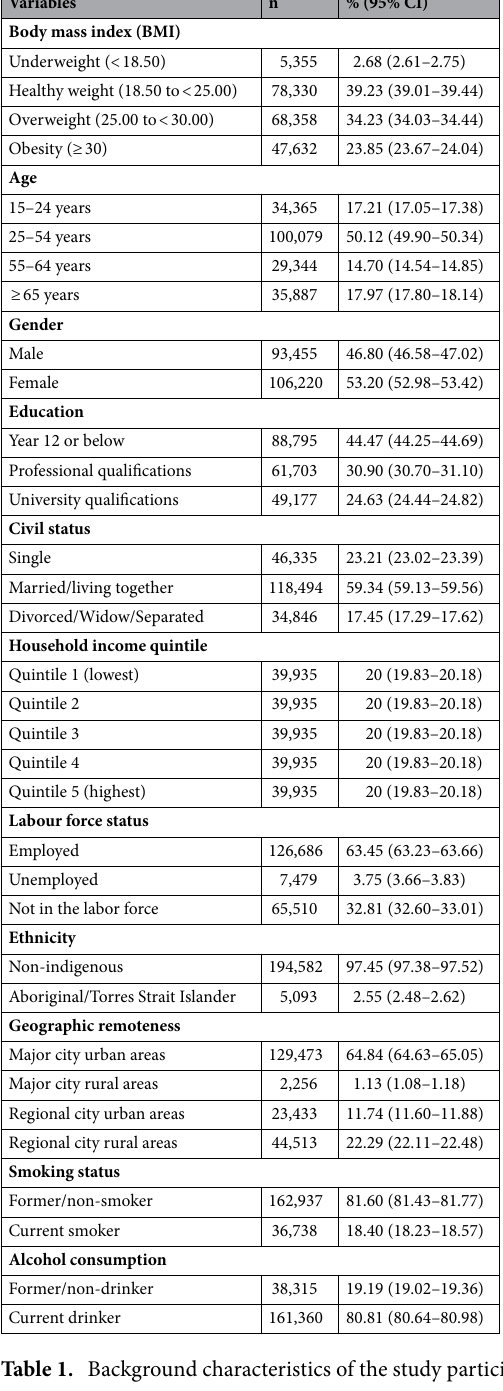
Table 1. Background characteristics of the study